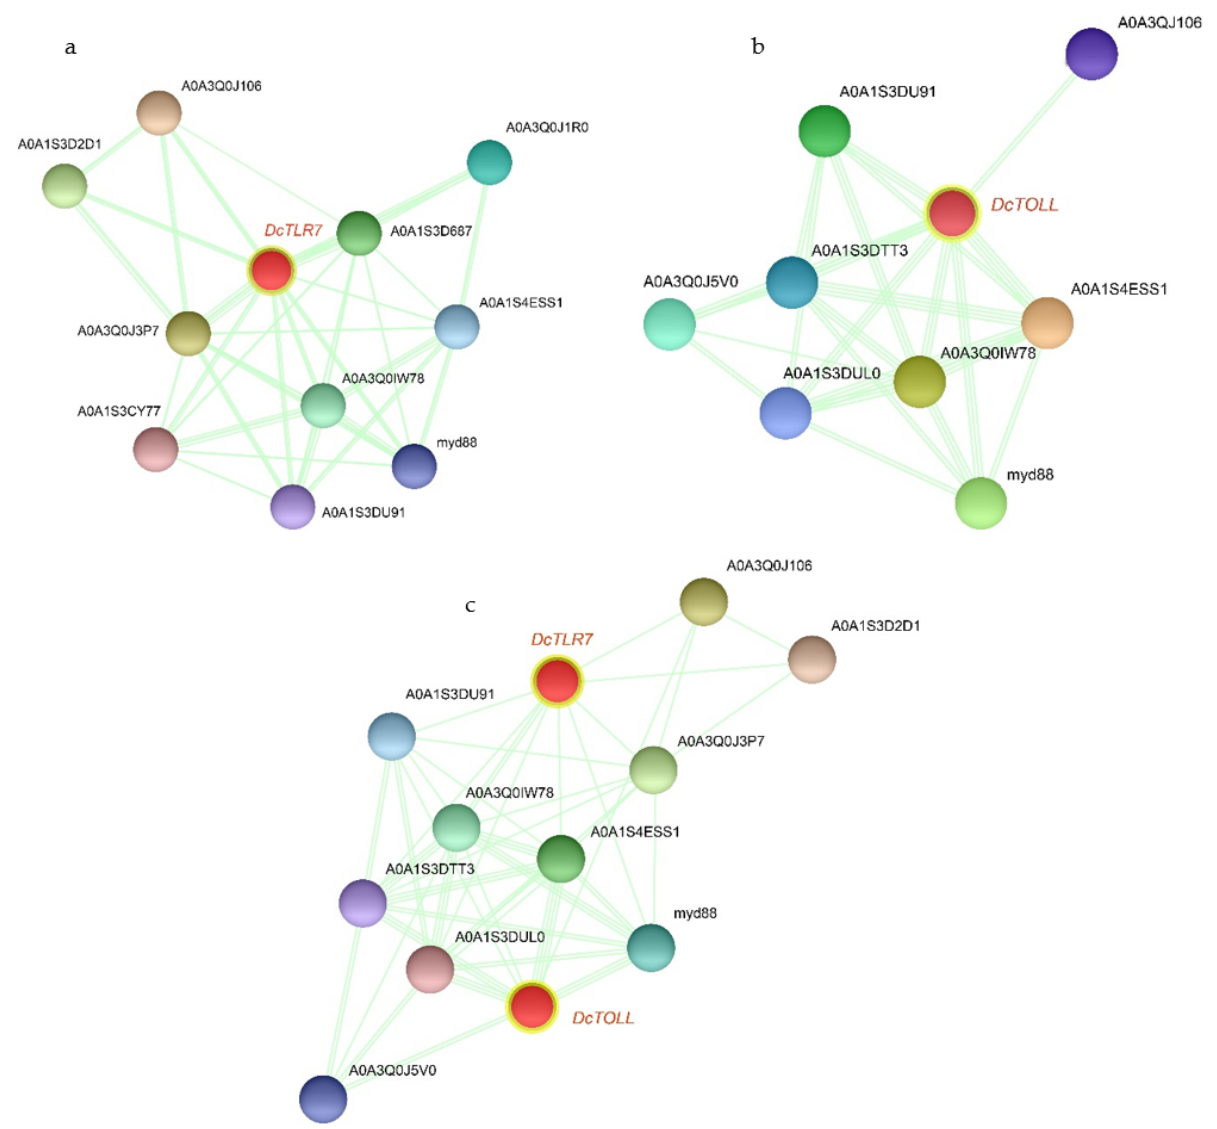
Figure 6. The PPI networks of DcTLRs . ( a , b ) The subnetworks DcTOLL and DcTLR7 . ( c ) The interaction network of the two DcTLRs .